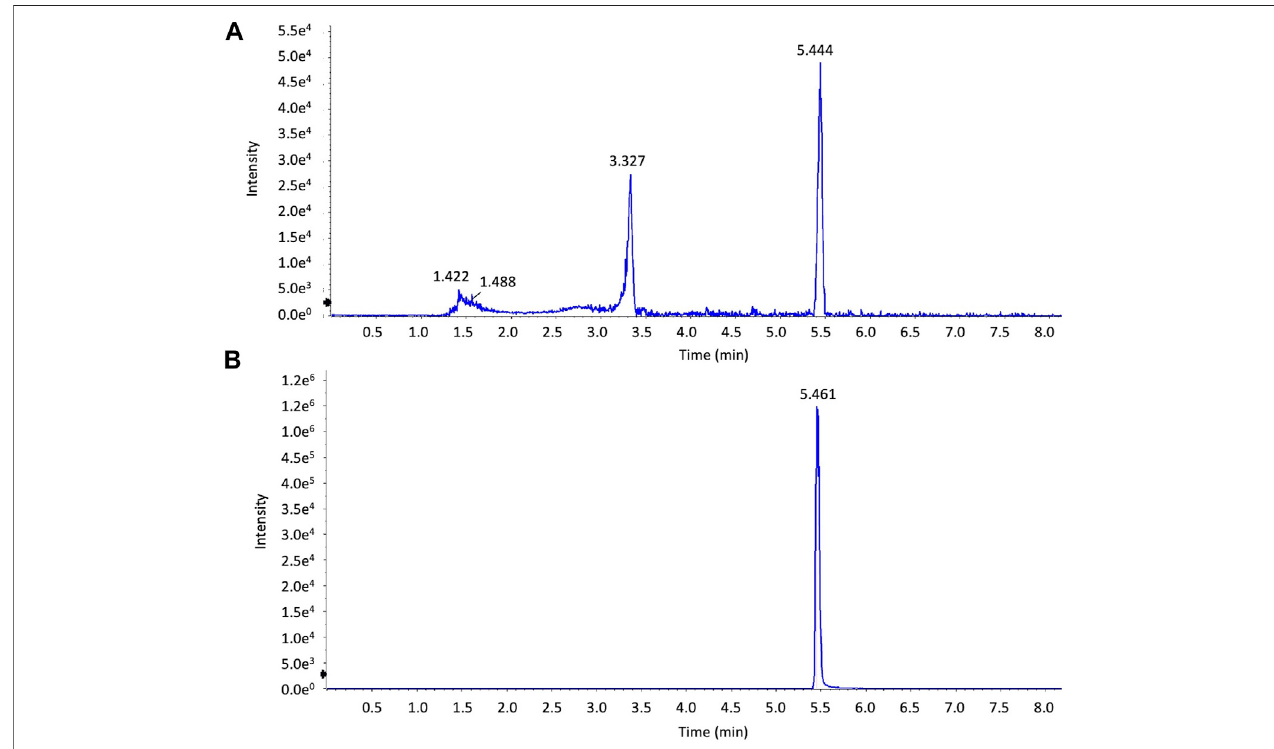
FIGURE 2 | HPLC analysis of extracts of Artemisia capillaris. Extracts of Artemisia capillaris and the standard compound 6,7-dimethylesculetin were subjected to HPLC analysis (Panels (A) and (B) respectively).